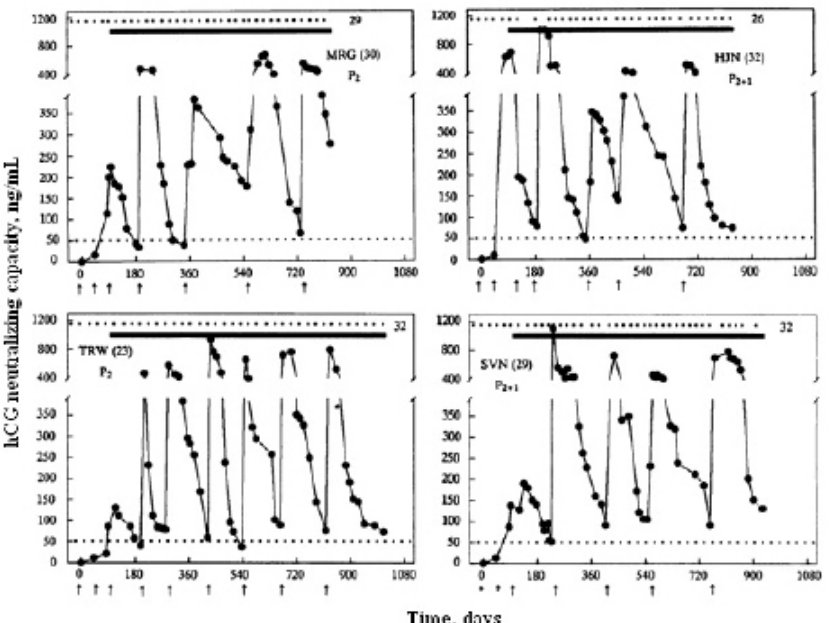
Figure 1. Anti-hCG response to the HSD vaccine in 4 sexually active women of proven fertility. MRG 30-yr-old and TRW 23-yr-old had 2 children each; MJN 32-yr-old and SVN 29-yr-old had 2 children each and 1 elective termination of pregnancy. All of them remained protected from becoming pregnant over 26-32 cycles. Dots at the top edge represent the menstrual events that remained regular, solid lines denote the period over which they were exposed to pregnancy. Arrows indicate the day on which the vaccine was given. Booster injections were given to keep antibody titers above 50 ng/mL Note . Reprinted from “A vaccine that prevents pregnancy in women” by Talwar GP, Singh O, Pal R, Chatterjee N, Sahai P, Dhall K, et al. Proc Natl Acad Sci U S A. 1994;91:8532-6 (https://doi.org/10.1073/pnas.91.18.8532). © 1994 National Academy of Sciences.